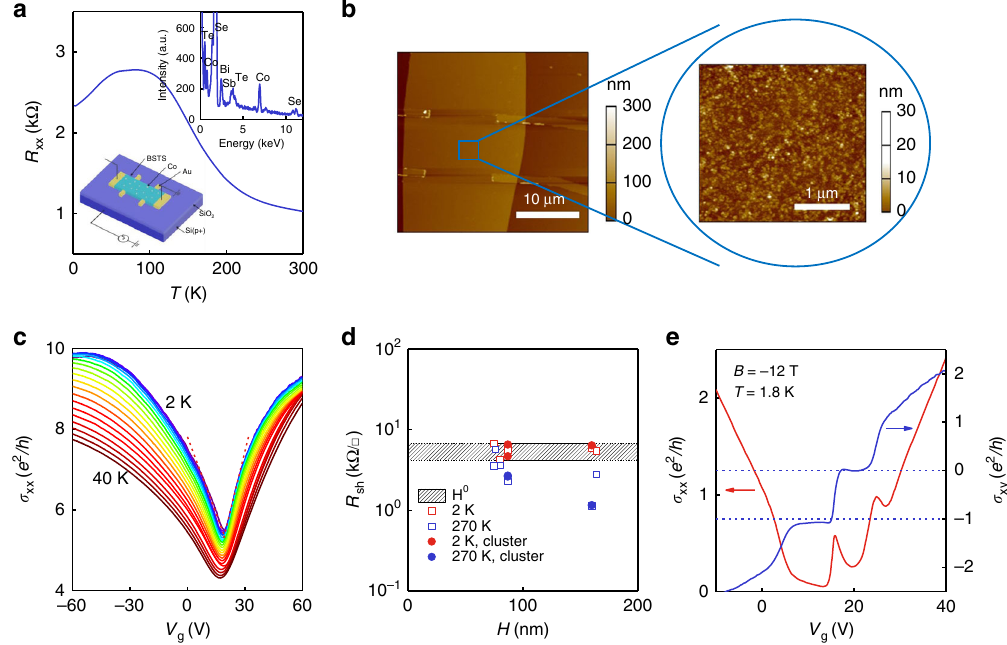
Fig. 1 Surface dominant transport and quantum Hall effect in the BSTS device. a A typical curve of temperature-dependent resistance. The inset shows the backgate measurement con fi guration and the elemental composition of the sample. b Atomic force microscopic image of the device. The zoom-in of ( b ) shows the granular morphology of the sample surface. The sizes of the clusters are in the tens of nanometers and their heights are about 5 nm. The scale bar on the left is 10 μ m (1 μ m in the zoom-in). c Gate-dependent conductivity from 2 to 40 K with a step of 2 K, exhibiting the bipolar characteristic. The minimum conductivity appears at a gate voltage of around 16.6 V. d The sheet resistance of several samples (some of them measured before the Co cluster deposition). Red dots are the data measured at 2 K, all of which fall within a small range, with or without Co clusters. This indicates the dominance of the surface transport. The blue dots, measured at 270 K, fall outside the shadowed regime, however. H is the height of the samples, and H 0 denotes the zeroth power of H . e Quantum Hall effect observed at a temperature of 1.8 K and a fi eld of − 12